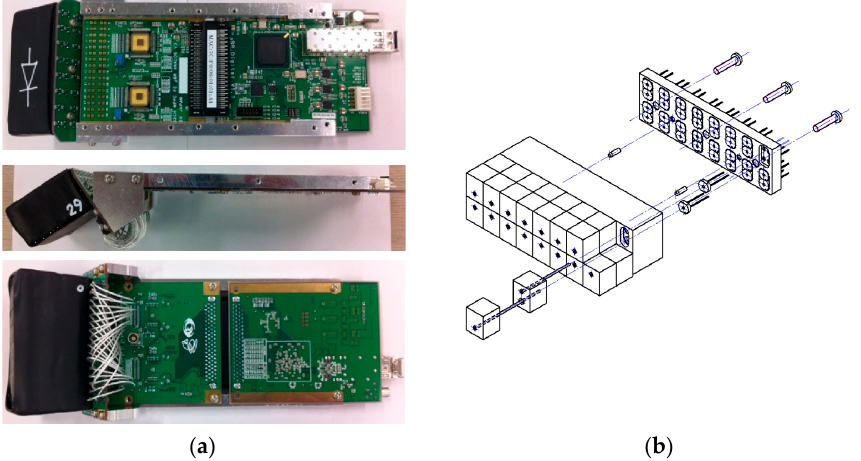
Figure 12. ( a ) One Kalliope (KEK Advanced Linear and Logic-board Integrated Optical detectors for Positrons and Electrons) detector, which consists of a scintillator block on a scinti-board, an analog board, and a digital board. Data are transferred to a data acquisition (DAQ) PC via an Ethernet cable. ( b ) A scintillator block consisting of 32 scintillator channels (with dimensions of 10 mm × 10 mm × 12 mm), each with wavelength-shifting fibers and pixel-type avalanche photo diodes (MPPC by Hamamatsu) installed.